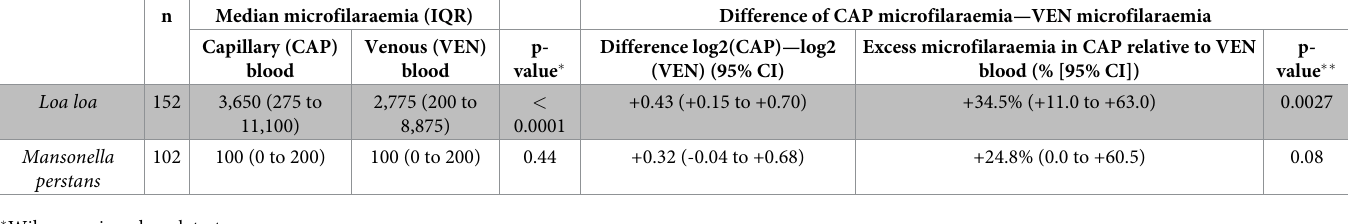
Table 2. Median and mean microfilaraemia in capillary (CAP) and venous (VEN) blood